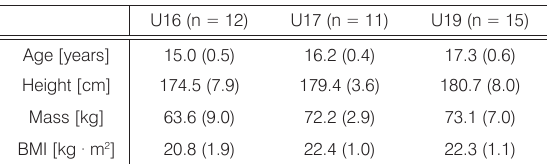
Table 2. Anthropometric data of players (n = 38). Values are mean